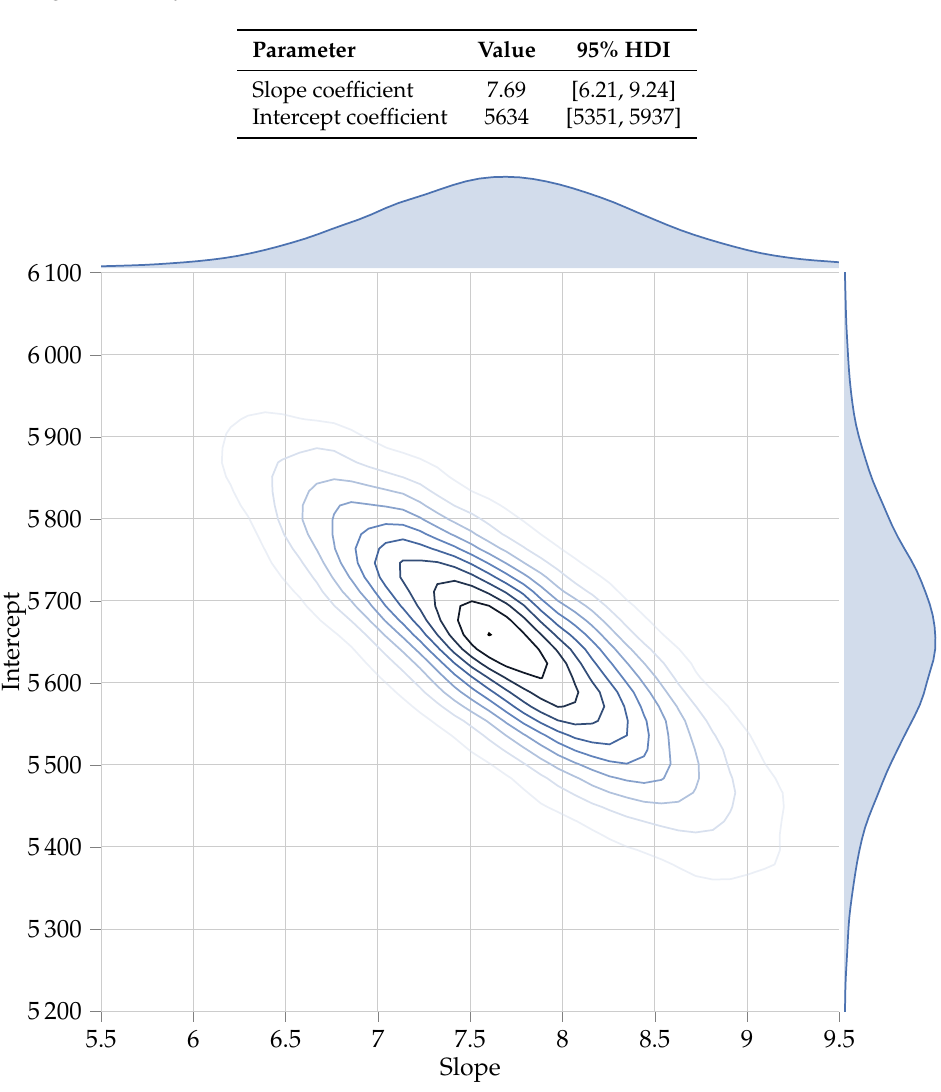
Table 3. Summary statistics for Bayesian posterior distributions shown in Figure 3 when a Student’s t -distribution is used on the likelihood. Compare to linear regression results in Table 2. HDI: Highest Density Intervals.